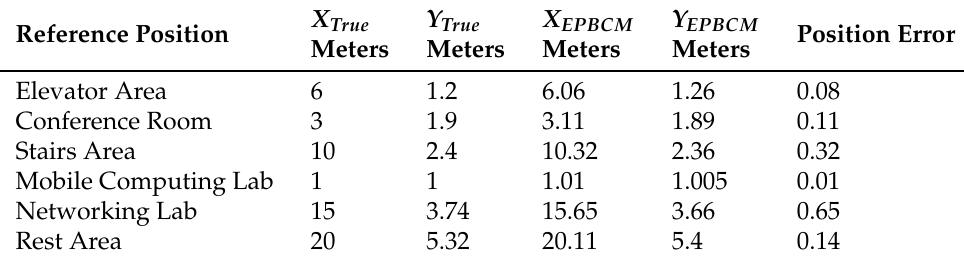
Table 6. Comparion in Position Error-Reference and